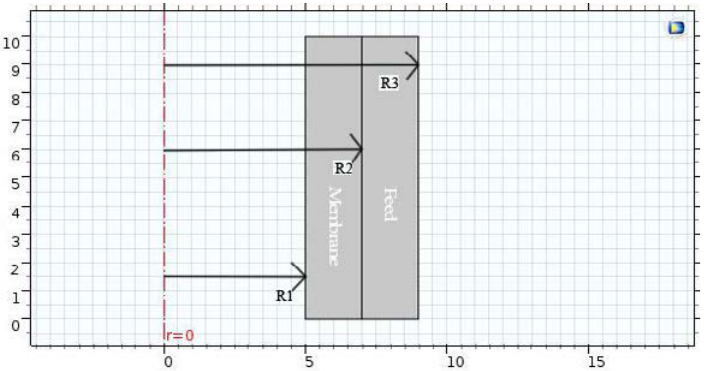
Fig. 2: Vertical diagram of the geometry of the model domain used in